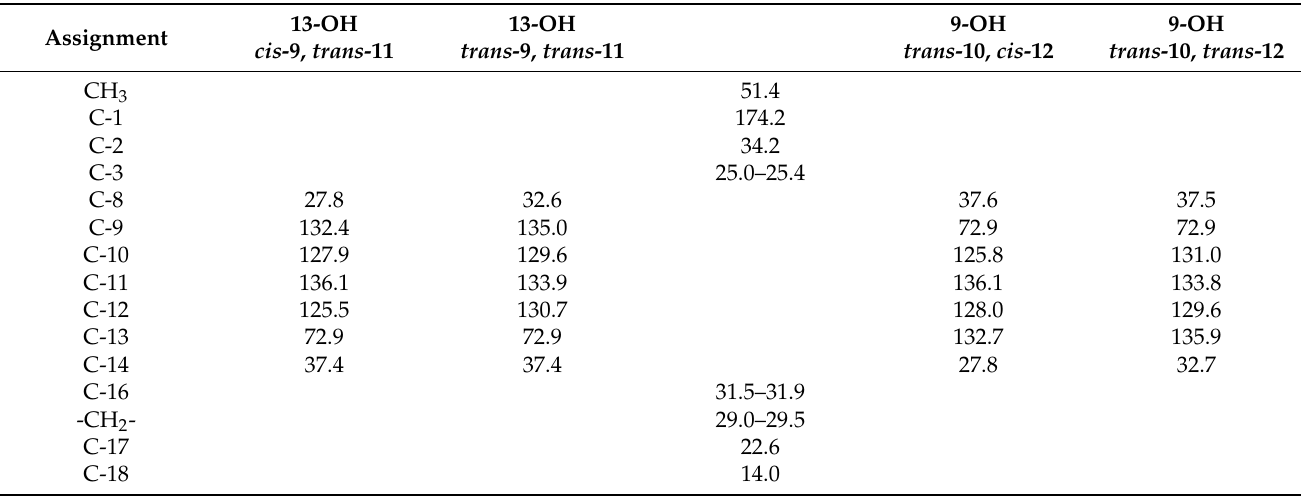
Table 2. 13 C-NMR chemical shifts (ppm) of geometric dienol isomers from autoxidized methyl linoleate. Reprinted, with permission, from [99]. Copyright 1990,